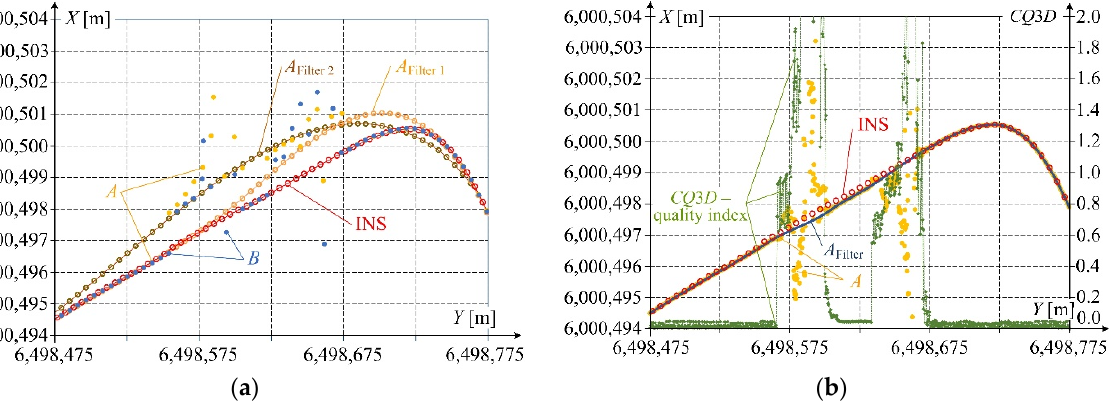
Figure 7. Results of filtering: ( a ) the trajectories A Filter 1 and A Filter 2 obtained by the Whittaker algorithm with the coordinates of the receivers A and B and INS (details see in Figure 4) in RTN mode every 1 s; ( b ) the trajectory A Filter after post-processing of signal recorded with 20 Hz frequency by receiver A , against the 1–s INS results, additionally, the quality indicator CQ3D is